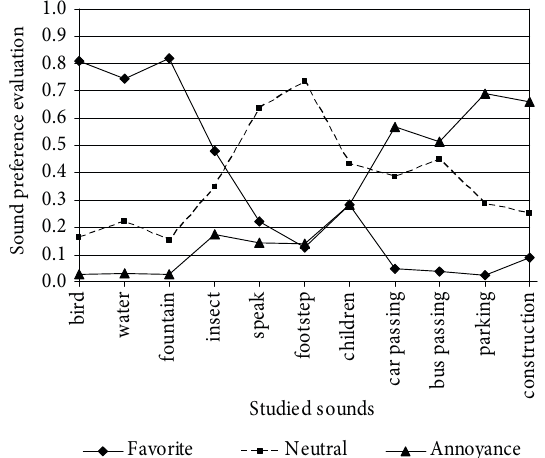
Fig. 1. Subjective evaluations on studied sounds